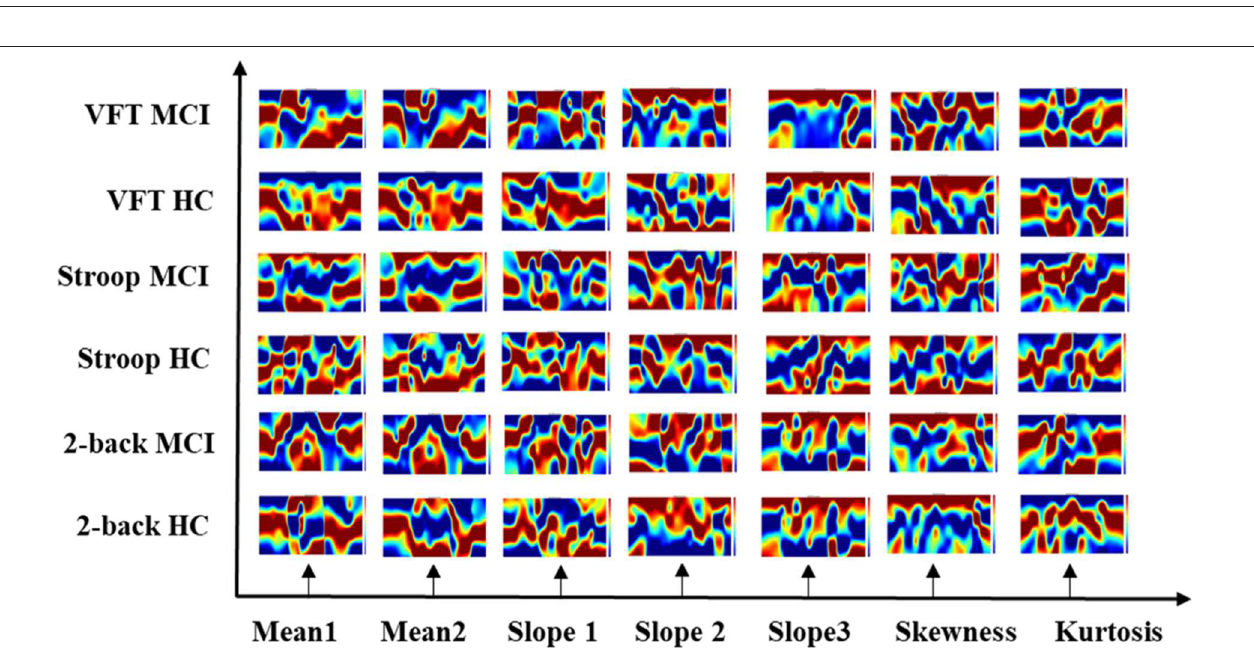
FIGURE 9 | Neuroimaging of temporal features (i.e., mean value from 5 to 65s, mean value from 5 to 25s, slope value from 5 to 15s, slope value from 20 to 60s, slope value from 60 to 70s, skewness value from 5 to 65s, and kurtosis from 5 to 65s) in spatial domain.